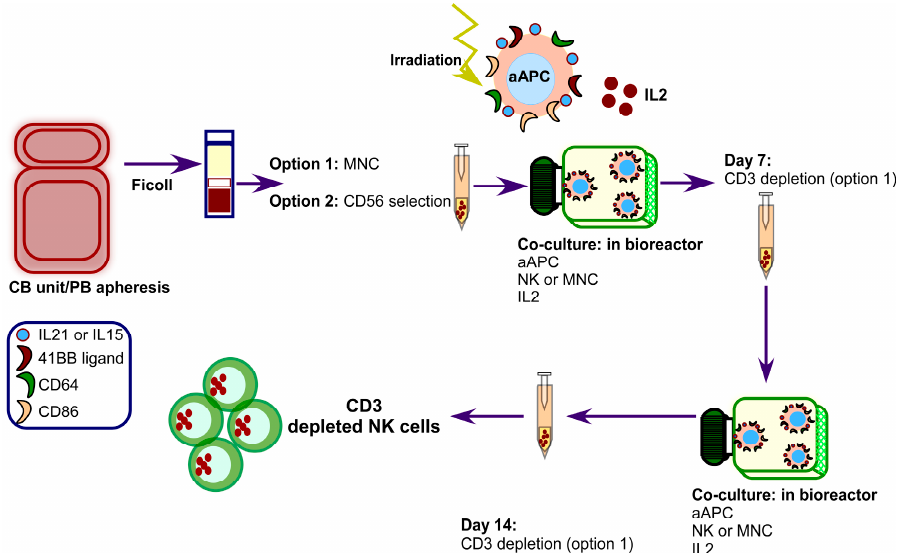
Figure 1. Clinical expansion of Natural Killer (NK) cells from apheresis products or cord blood (CB) units. Activated NK cells can be generated starting either from mononuclear cells (MNC) or with magnetically selected NK cells. First, either CB or apheresis products are ficolled to get the MNC, and then they are either added directly to a bio-reactor or subjected to magnetic CD56+ selection. These CD56+ cells will be added to the bio-reactor. Then, they are expanded in vitro for seven days with artificial antigen presenting cells (aAPCs). IL2 is added exogenously every other day. aAPCs